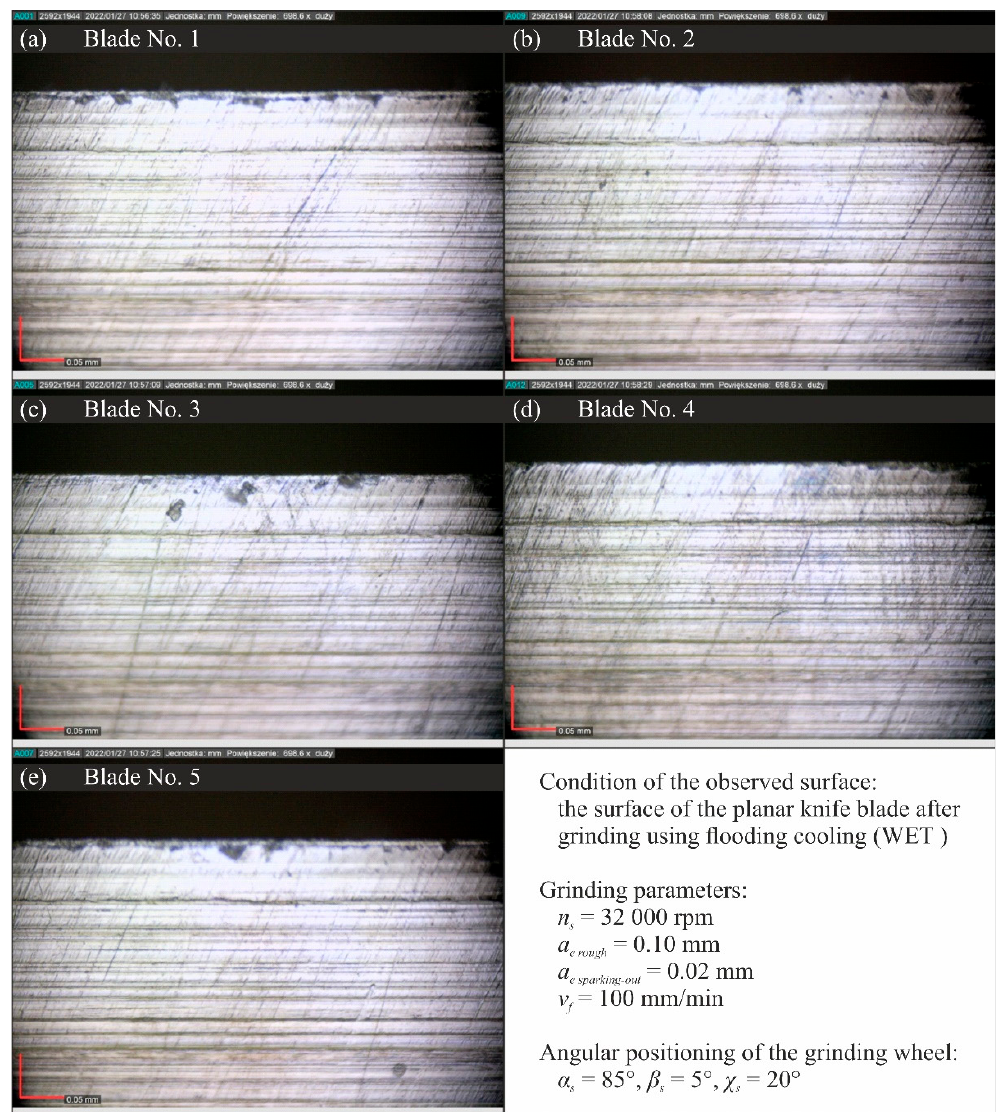
(WET—Figure 15, MQL—Figure 16, CAG—Figure 17 and MQL + CAG—Figure 18).